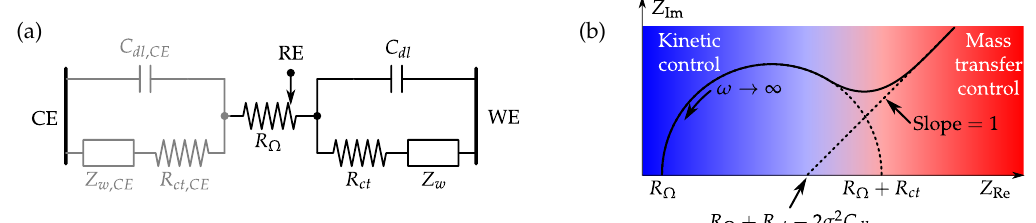
Figure 5. Randles equivalent circuit and Nyquist plot of electrochemical cell impedance seen between Counter electrode (CE) and working electrode (WE): ( a ) schematic; ( b ) characteristic on the real-imaginary